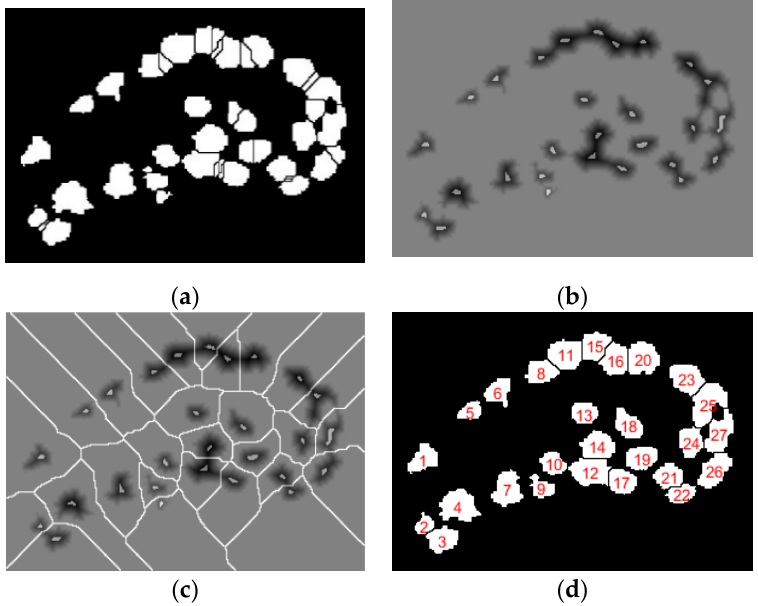
Figure 5. Improvement of over-segmentation: ( a ) over-segmented objects; ( b ) markers applied to the inverse results of the distance transform; ( c ) applied watershed algorithm on images (b); and ( d ) the resulting image after removing the noise and watershed line, and the centroid of the nucleus has been labelled.